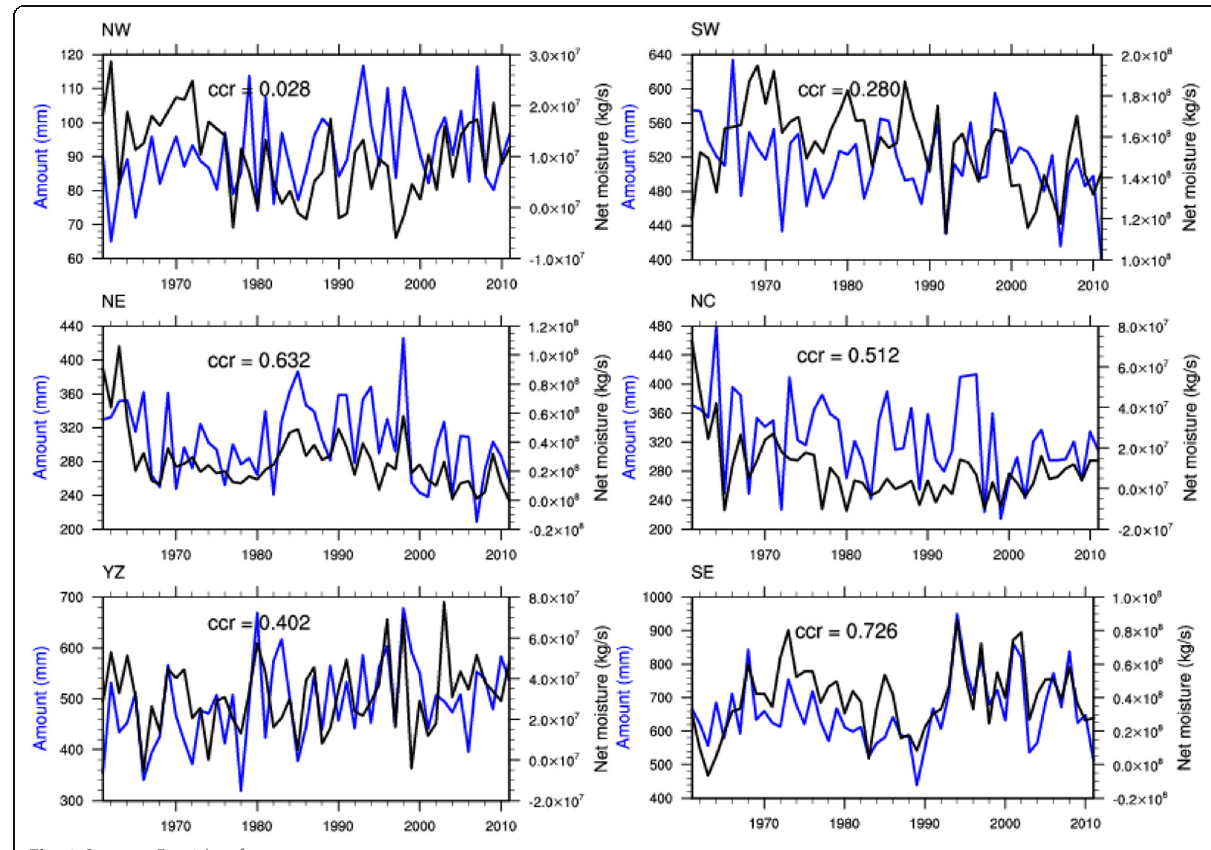
Fig. 9 Same as Fig. 8 but for summer